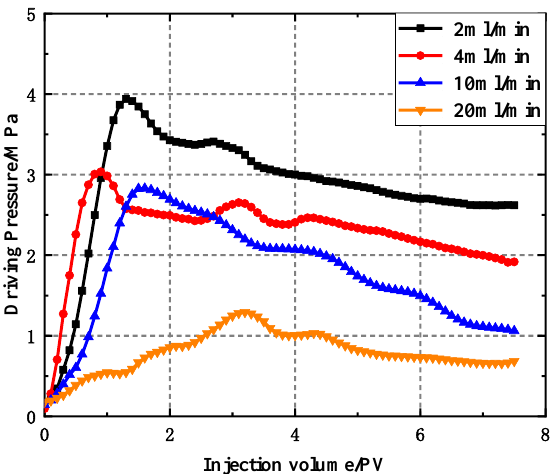
Figure 12. Relationship between the gas injection rate and injection amount during water injection.